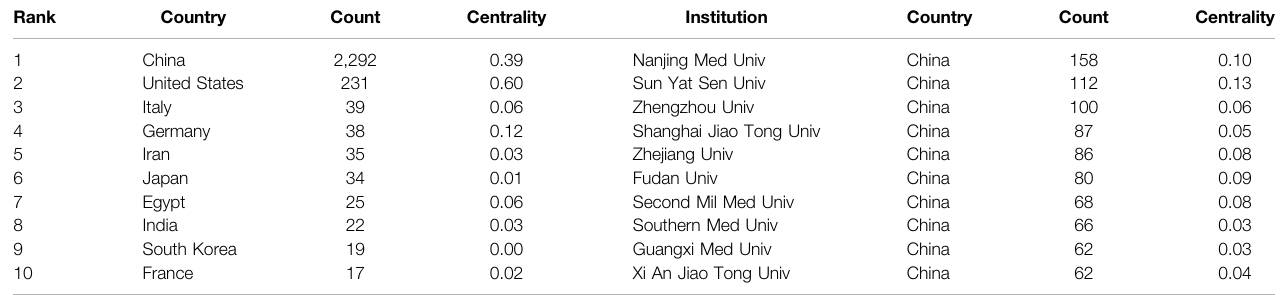
TABLE 1 | The top 10 countries and institutions involved in the roles of lncRNAs in HCC development research.